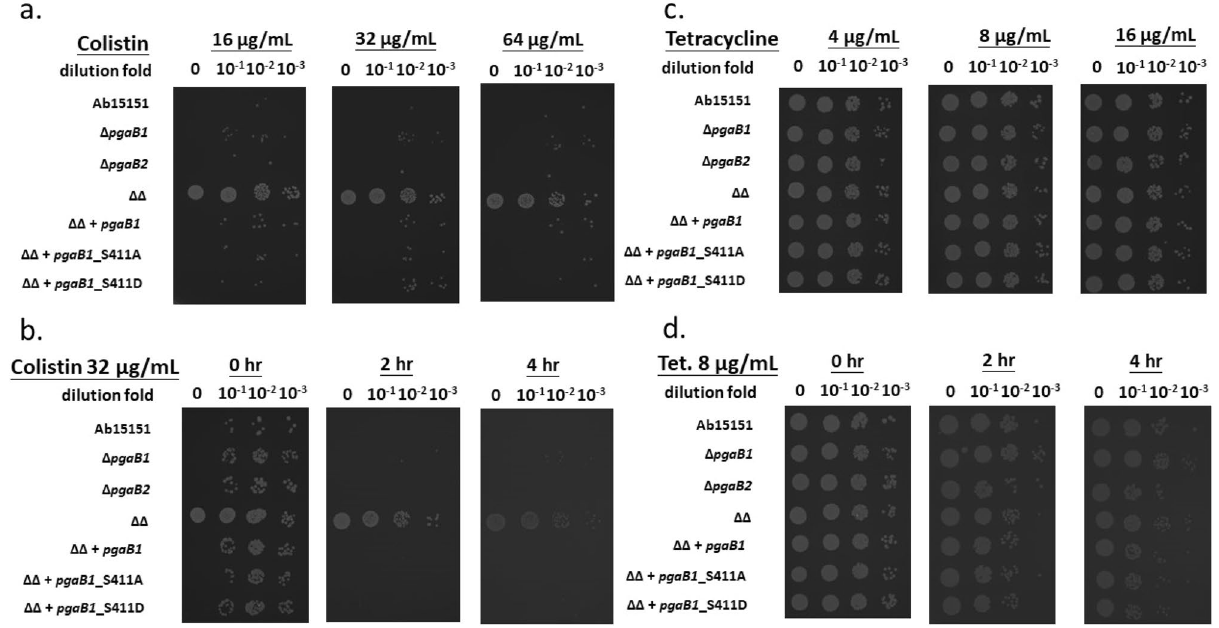
Figure 4. Time-dependent post-antibiotic effects of colistin and tetracycline to A. baumannii strains in this study. The overnight cultures were diluted to OD 600 0.1 for colistin or 0.01 for tetracycline administration. After a 1 h treatment with colistin ( a ) or tetracycline ( c ), the cultures were tenfold serially diluted to spot on the LB agar plate. With the administration of 32 µg/mL colistin ( b ) or 8 µg/mL tetracycline ( d ) within 4 h, all tested strains were tenfold-diluted and incubated overnight for evaluating their survival